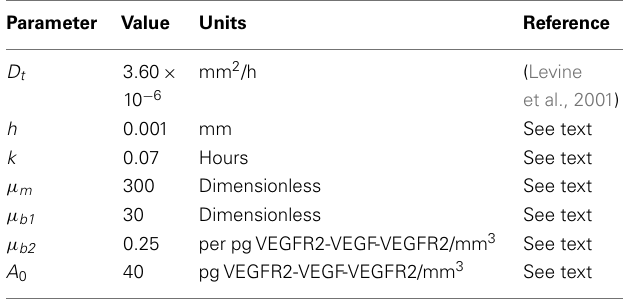
Table 3 | List of parameter values for capillary